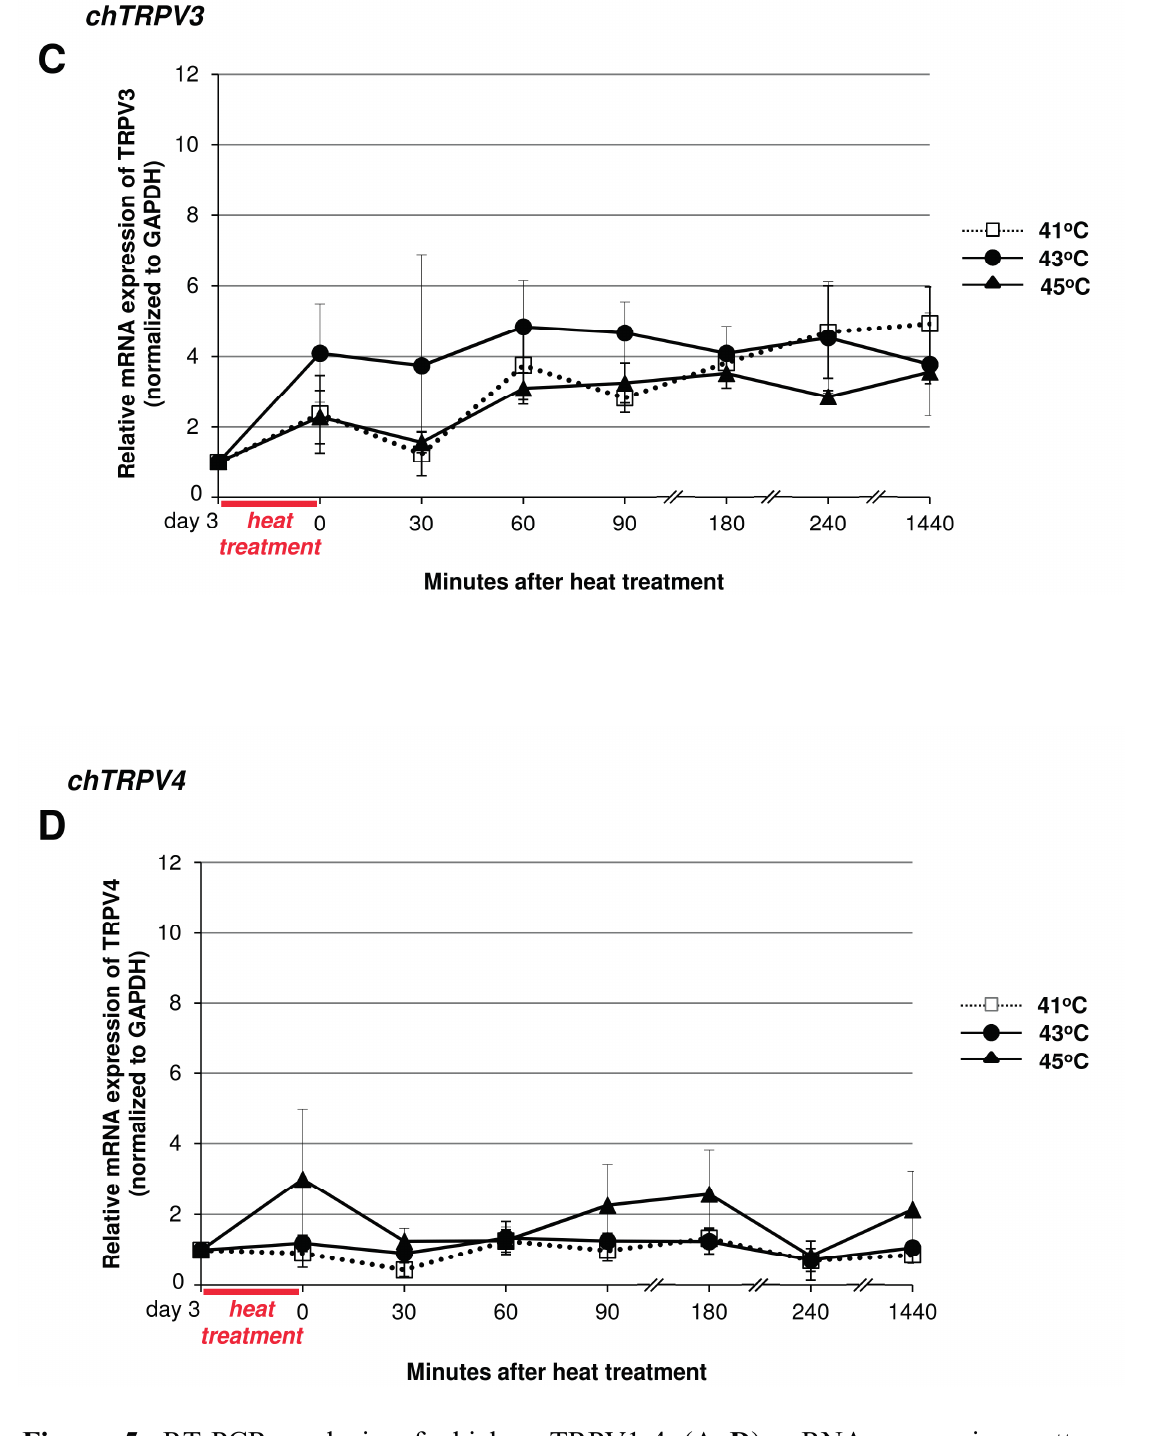
Figure 5. RT-PCR analysis of chicken TRPV1-4 ( A – D ) mRNA expression